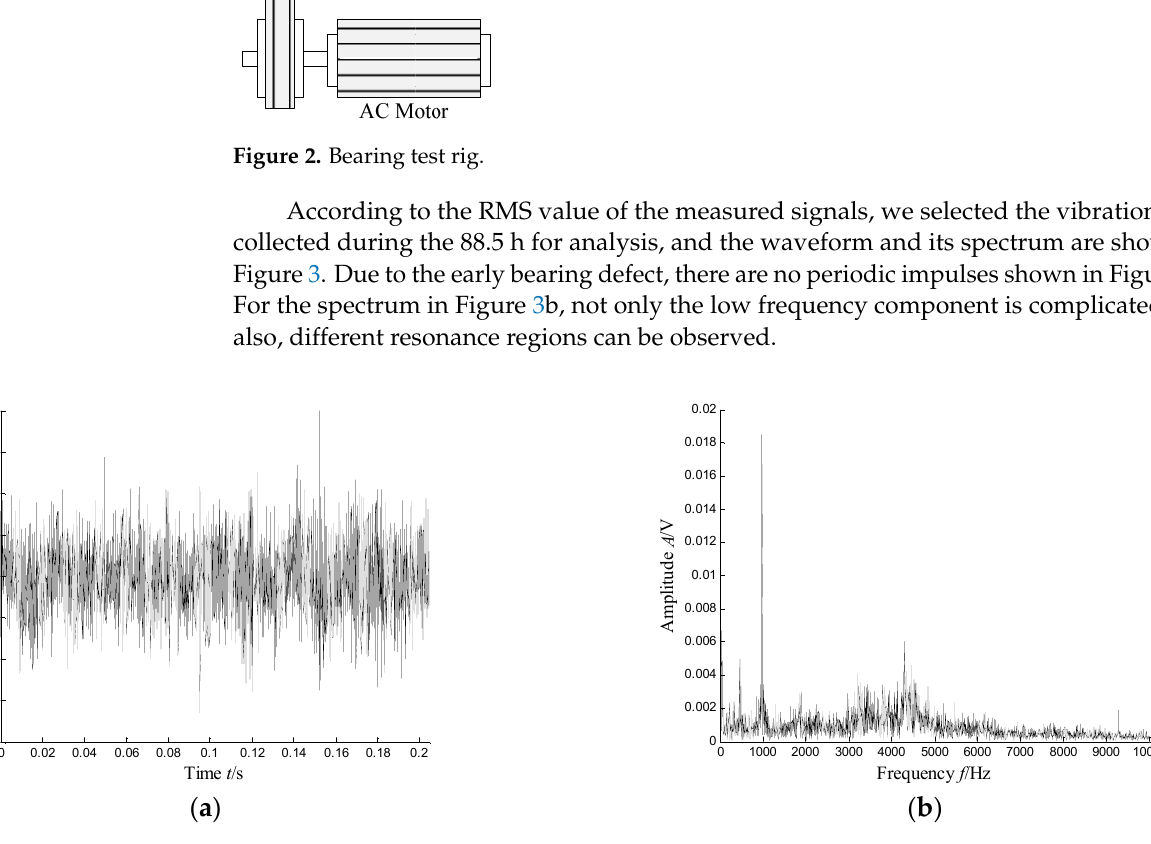
Figure 3. Waveform and spectrum of the outer race defect: ( a ) waveform and ( b ) spectrum.